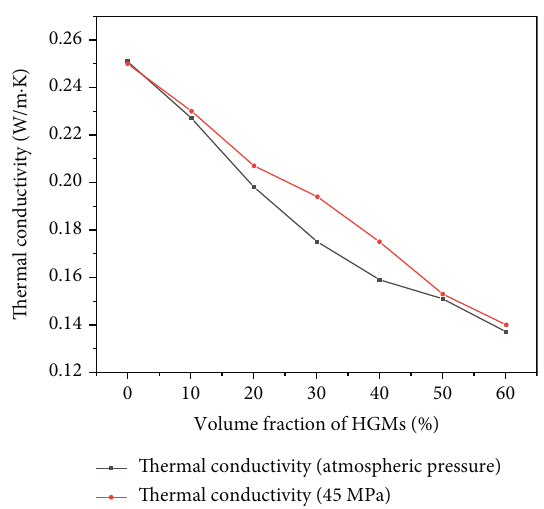
Figure 12: Thermal conductivity curves of the HGM/EP composite insulation